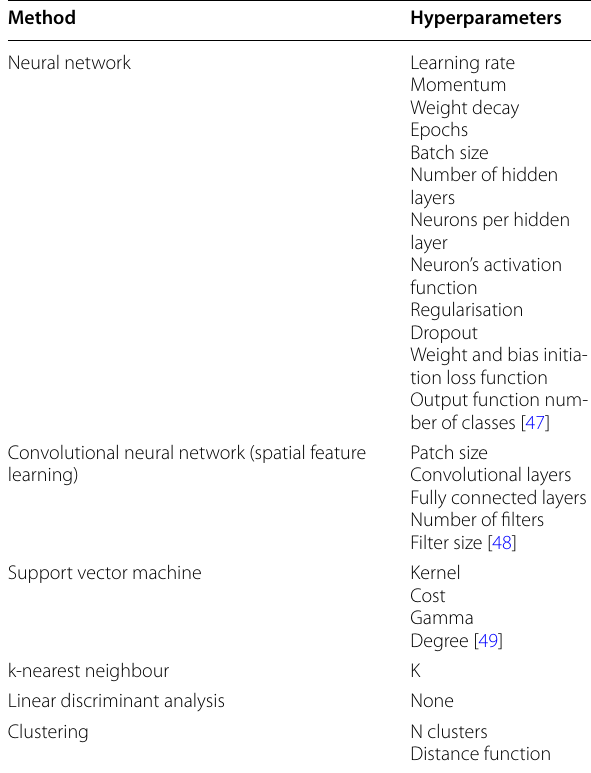
Table 2 Examples of hyperparameters of machine learning